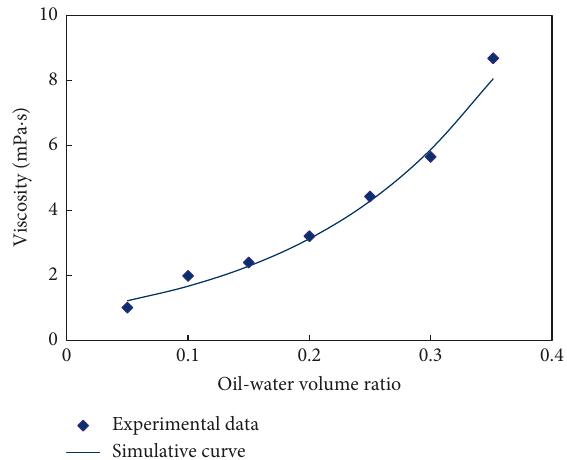
Figure 3: Relationship curve between viscosity and oil-water volume ratio.